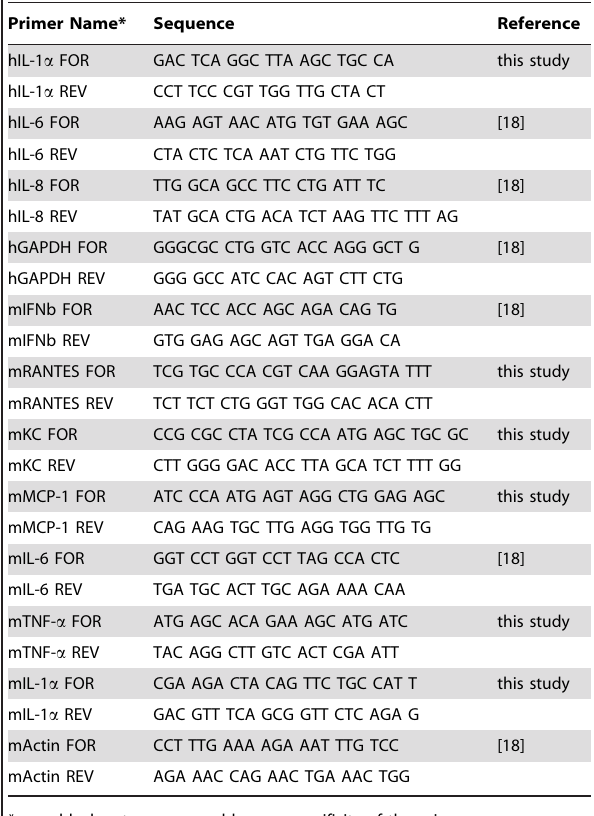
Table 1. Primers used for